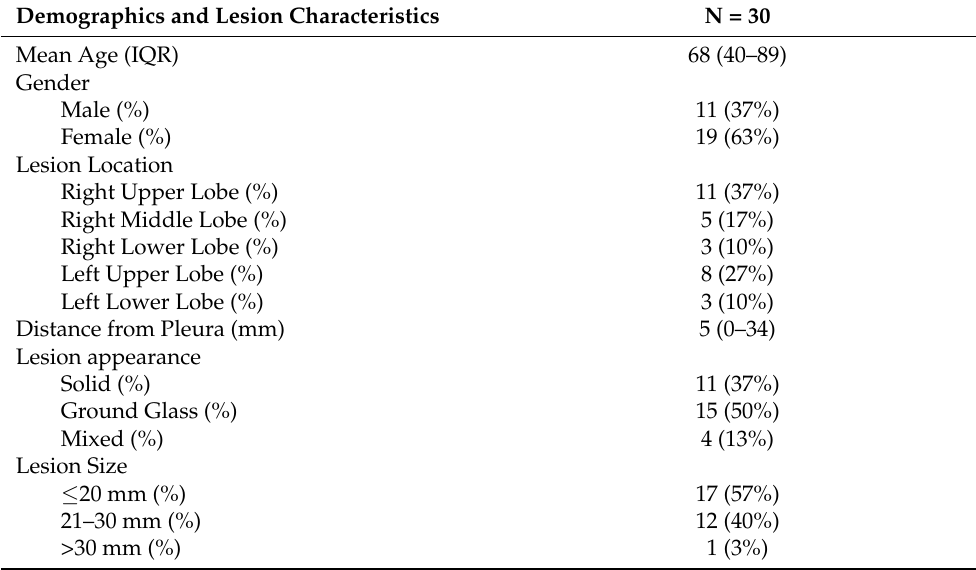
Table 1. Patient Demographics and Lesion Characteristics.